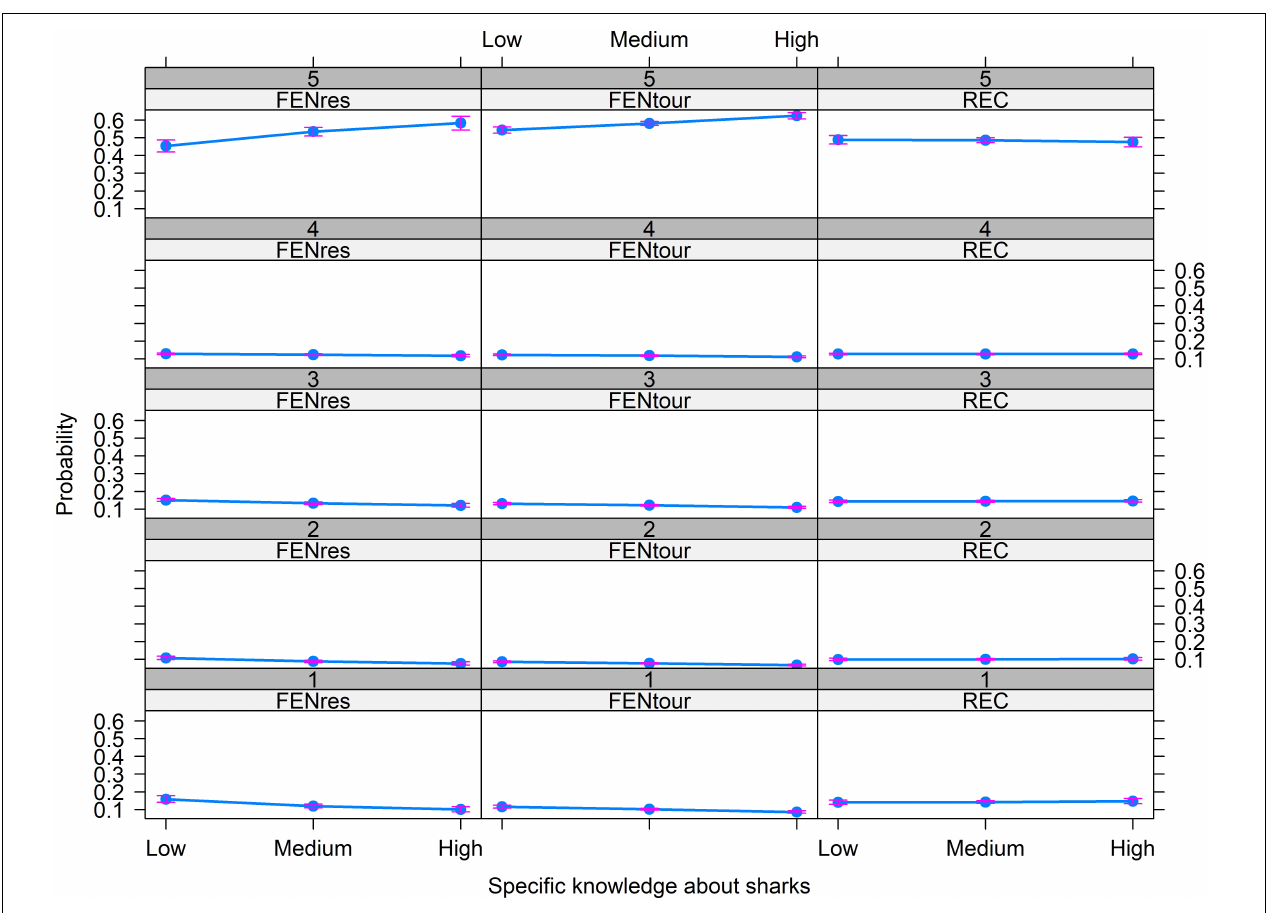
FIGURE 2 | Effects of the interaction of sampling treatment (i.e., Recife – REC, tourists of Fernando de Noronha – FENtour, and residents at Fernando de Noronha – FENres) with specific knowledge about sharks (i.e., low, medium, and high) on the variability in knowledge about sharks, assessed with a Likert-based ordered logistic regression model. The Likert scale spans from 1 through 5, with 5 being the most positive/correct option. The vertical axes represent the probability of respondents selecting each of the Likert options. The three panel columns correspond to sampling treatments (FENres, FENtour, and REC from the left through the right columns), whereas the five panel rows correspond to Likert options (ordered in descending order from the top through the bottom rows). Note that specific knowledge about sharks is a predictor variable derived with questions on specific quantitative metrics about sharks, whilst knowledge about sharks is a response variable derived with Likert questions about more general aspects of sharks. The complete model also included ocean proximity as a predictor